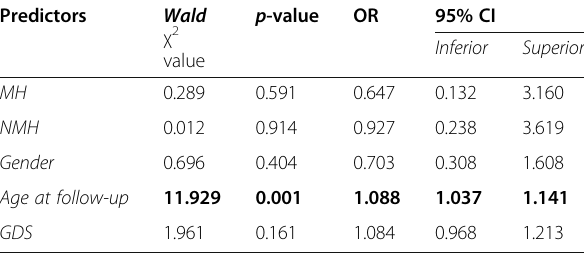
Table 2 Predictors of cognitive impairment (multivariable logistic regression